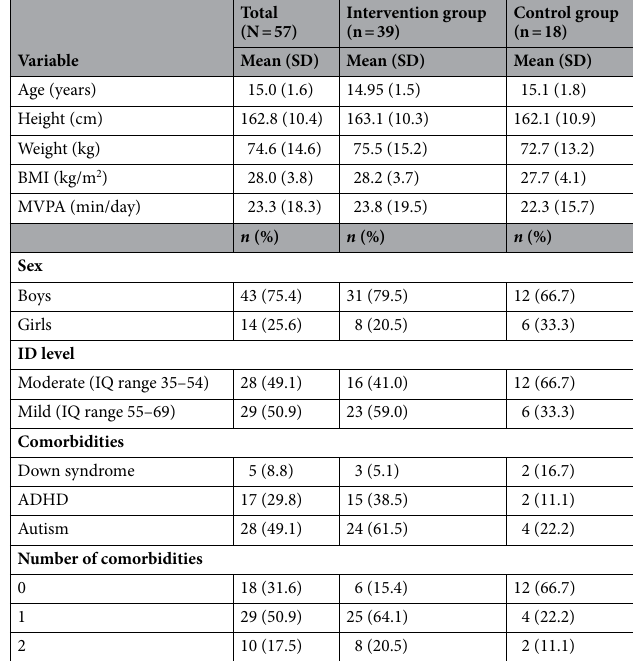
Table 1. Characteristics at baseline of study participants. SD, standard deviation; BMI, body mass index; MVPA, moderate-to-vigorous physical activity; ID, intellectual disability; IQ, intelligence quotient; ADHD, attention deficit/hyperactivity disorder.